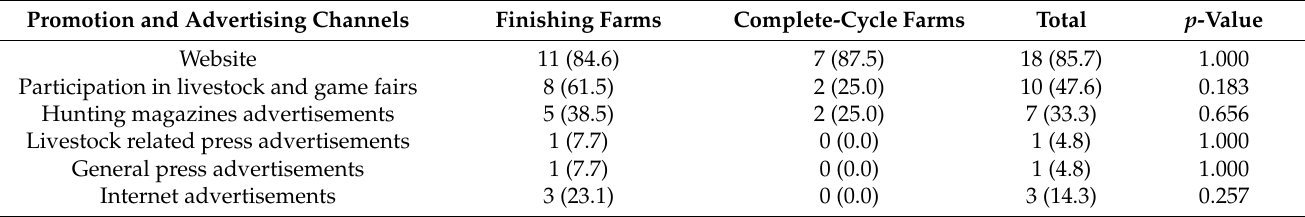
Table 9. Frequency (n, and % between parentheses) of variables related to the advertising and promotional channels of the quail game farms (n =